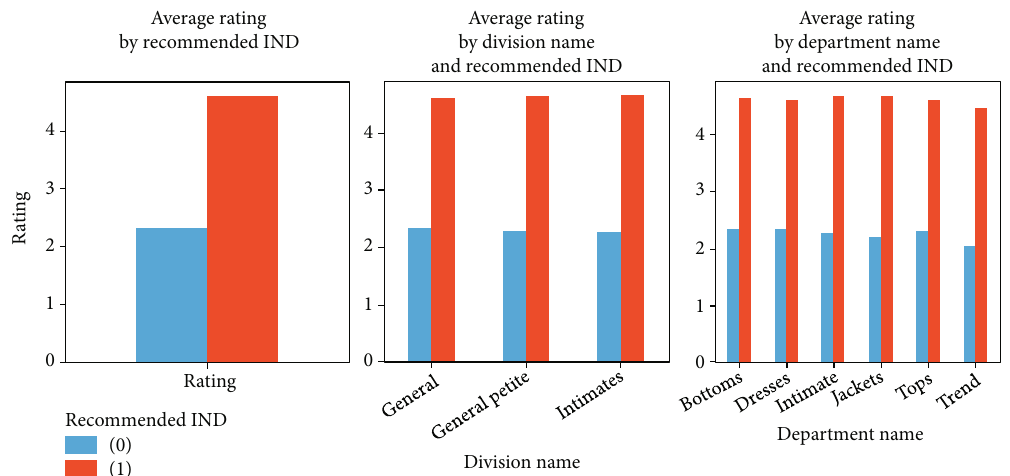
Figure 18: The improvement of recommendations and ratings.